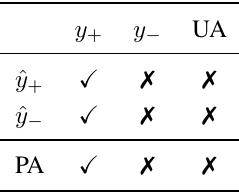
with ( · ) being the positive ( + ) ( · ) samples +